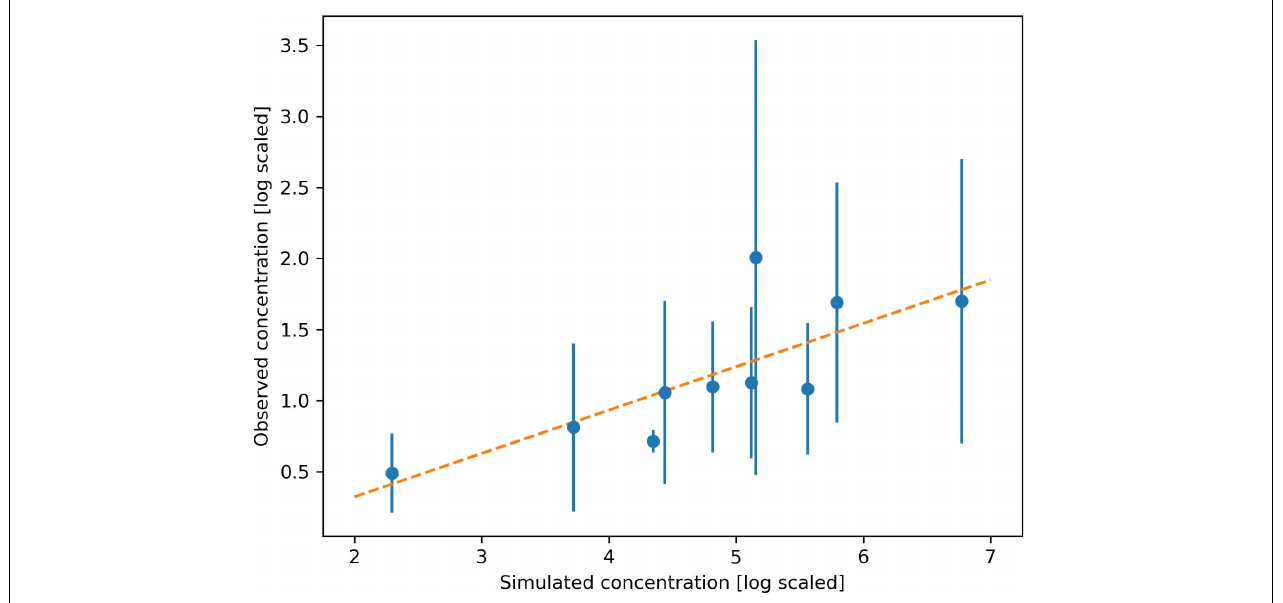
FIGURE 5 | Relationship between the observed and simulated concentration of Lophelia pertusa eDNA at 10 sampling stations. Observed mean value and standard deviation from 2 replicate samples shown by dots and error bar. The linear regression model ( y = 0.31x + 0.29) is shown by the orange line (Spearman rank correlation coefficient = 0.85, p <